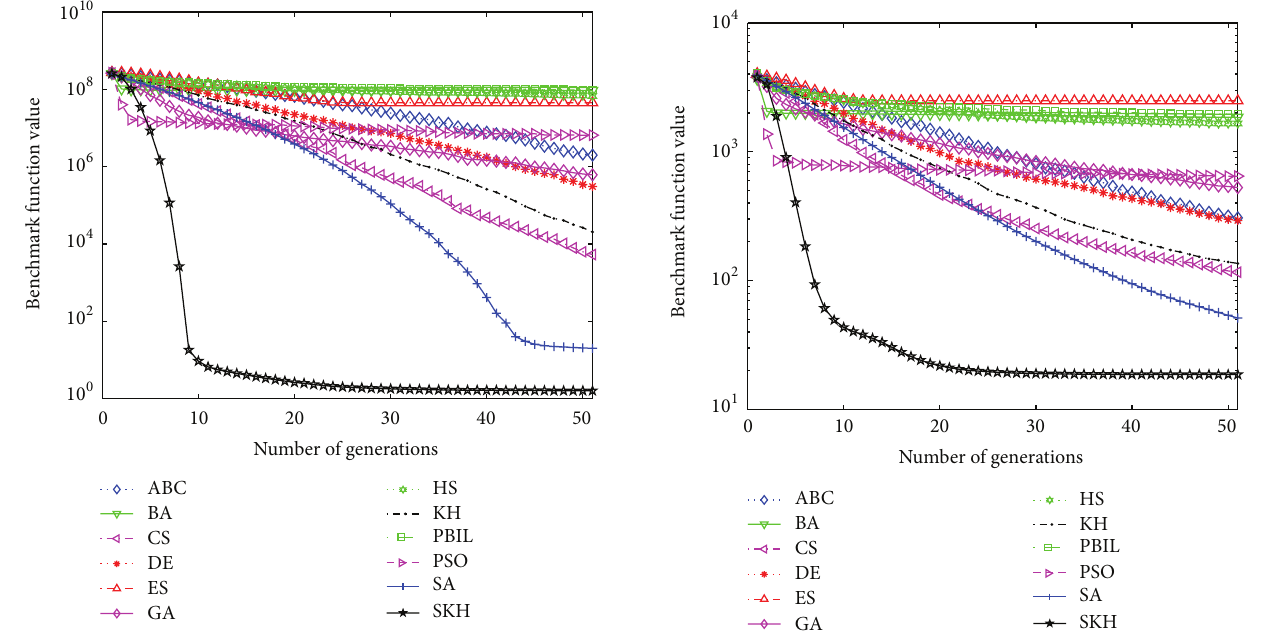
Figure 4: Comparison of the performance of the different methods for the F08 Rosenbrock